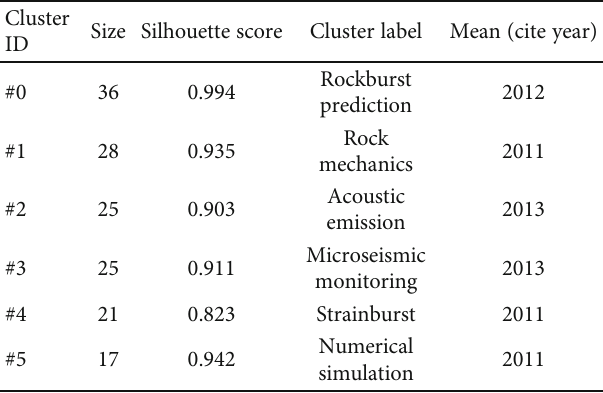
Table 5: Six main clusters in rockburst research of hard